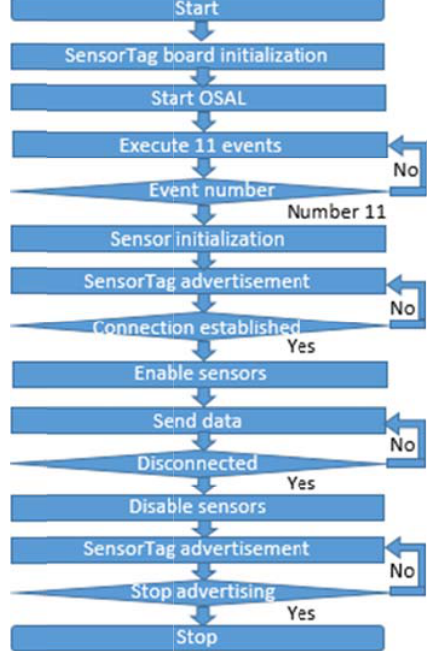
Figure 3. T firmware